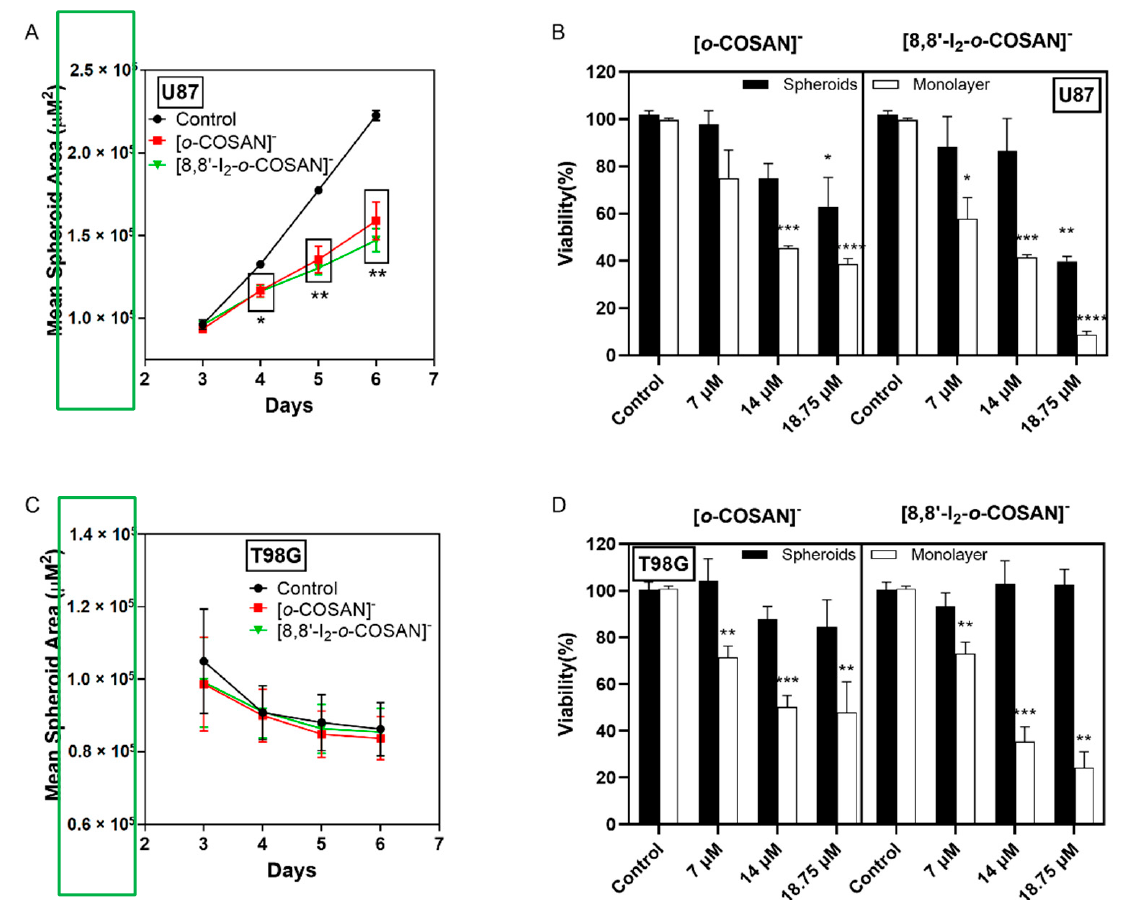
Figure 7. Effects of incubation of [ o -COSAN] − and [8,8 (cid:48) -I 2 - o -COSAN] − on U87 (top panels) and T98G (bottom panels) spheroids. ( A ) U87 and ( C ) T98G spheroids growth after incubation with IC 50 concentrations of [ o -COSAN] − and [8,8 (cid:48) -I 2 - o -COSAN] − , represented by the mean spheroids area (in µ M 2 ) as a function of the number of days in culture, and ( B ) and ( D ) cellular viability (%) at 72 h, assessed by the APH assay, in parallel to monolayer cultured cells. Controls consist of spheroids or monolayer cultured cells incubated only with medium. Data are presented as the average ± SEM of 3 independent assays. Statistical significance was calculated using one-way ANOVA, followed by Dunnett’s test comparing treated spheroids/cells with control spheroids/cells (* p ≤ 0.05, ** p ≤ 0.01, *** p ≤ 0.001, and **** p ≤ 0.0001).